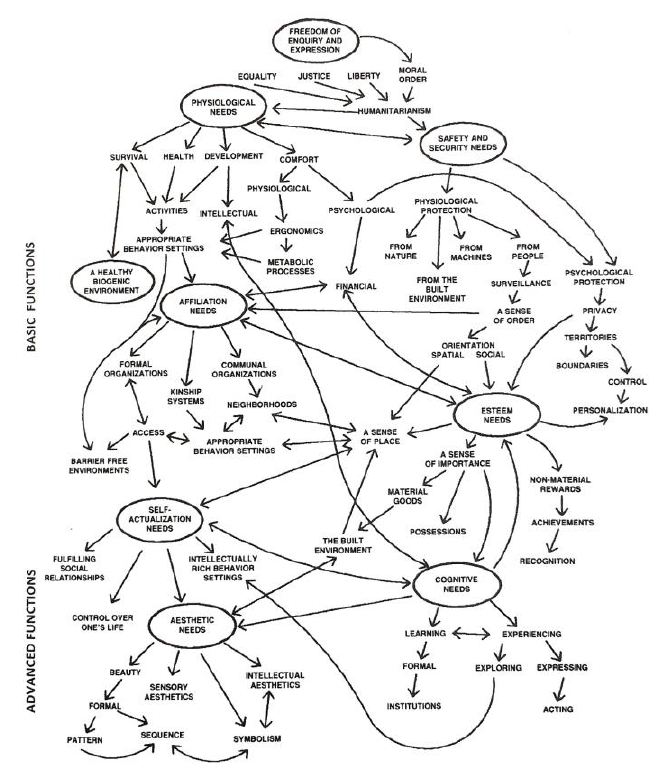
Figure 3. Human needs and the function of the built environment (Lang, 2017, p: